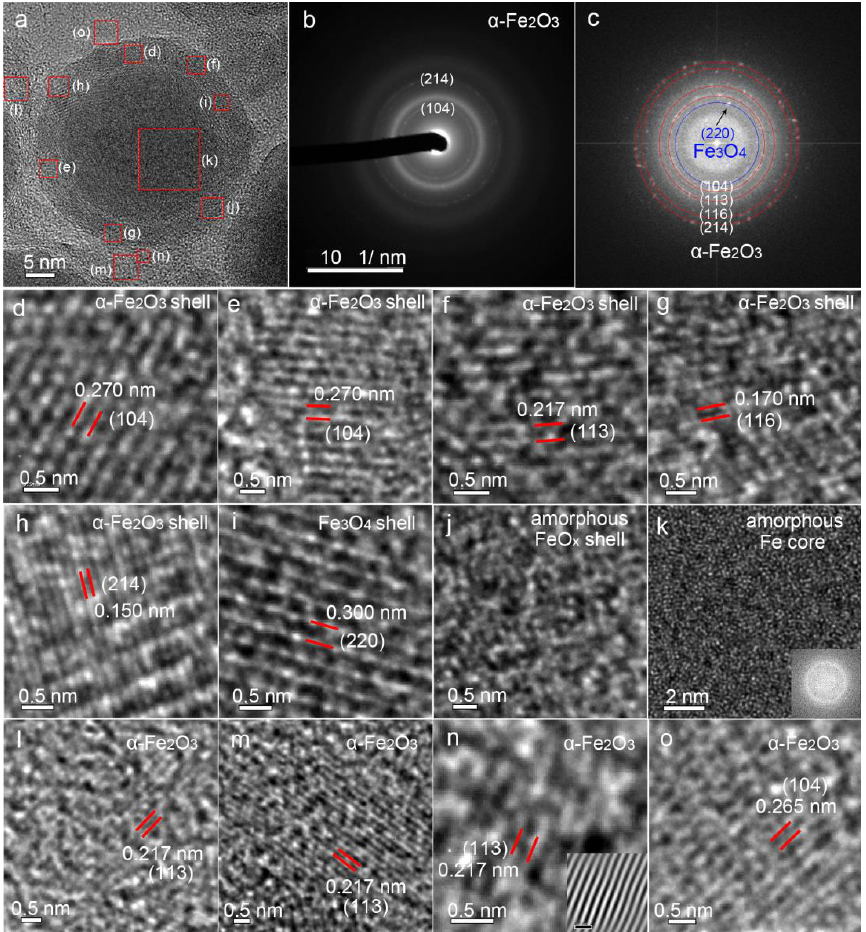
Figure 4. ( a ) High-resolution transition electron microscropy (HRTEM) image of a Fe@FeO x core-shell particle, ( b ) selected area electron diffraction (SAED) and ( c ) FFT analysis of the core-shell particle. HRTEM images of ( d – j ) α -Fe 2 O 3 shells, ( i ) Fe 3 O 4 shell and ( j ) amorphous FeO x shell and ( k )